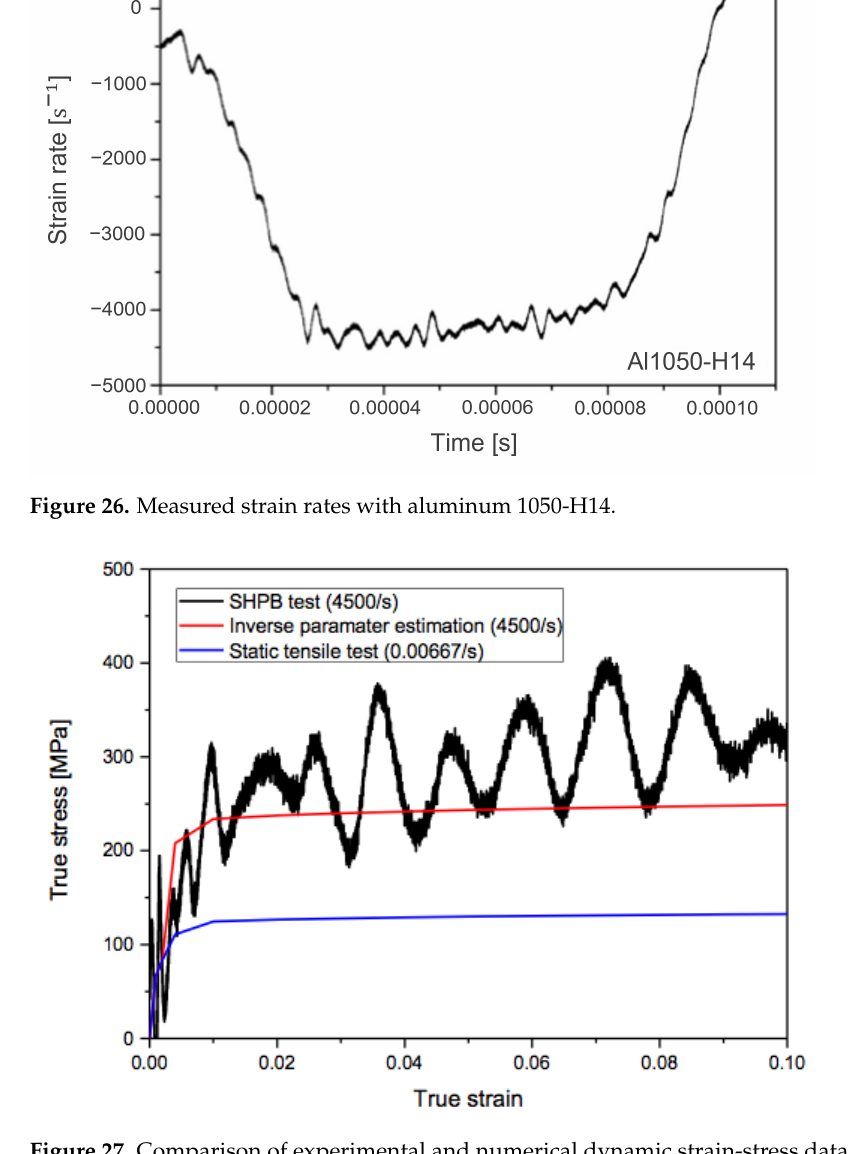
Figure 27. Comparison of experimental and numerical dynamic strain-stress data with aluminum